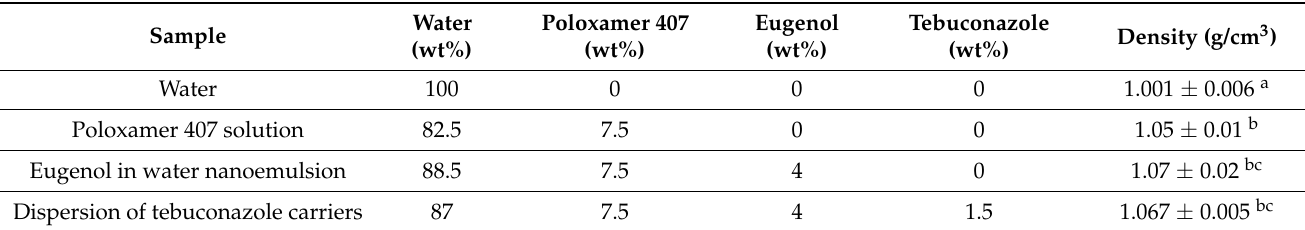
Table 2. Composition and density values as were obtained for water, poloxamer 407 solution, eugenol in water nanoemulsion and of dispersion of tebuconazole carriers. Each density value represents the average of 10 independent replicates with their respective standard deviation. Means in same column followed by different letters are significantly different by Student t -test for p <